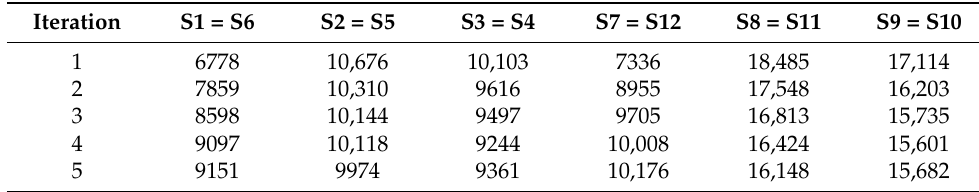
Table 3. Footing reactions evolution in the FEM model (kN).